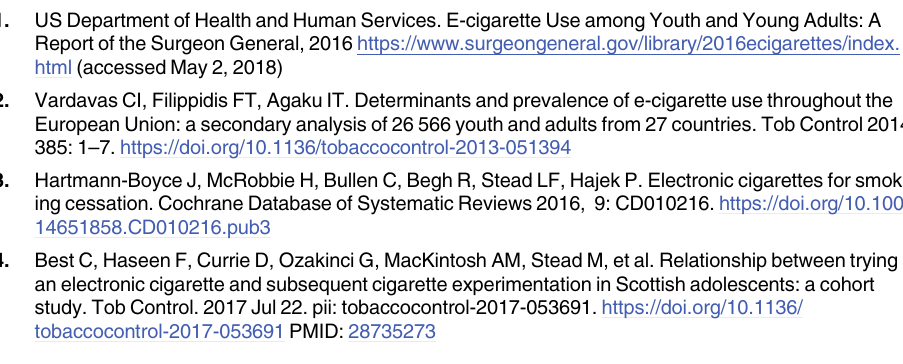
S1 Table. Description of parameters in the simulation model. S2 Table. Initial statistics of the simulation